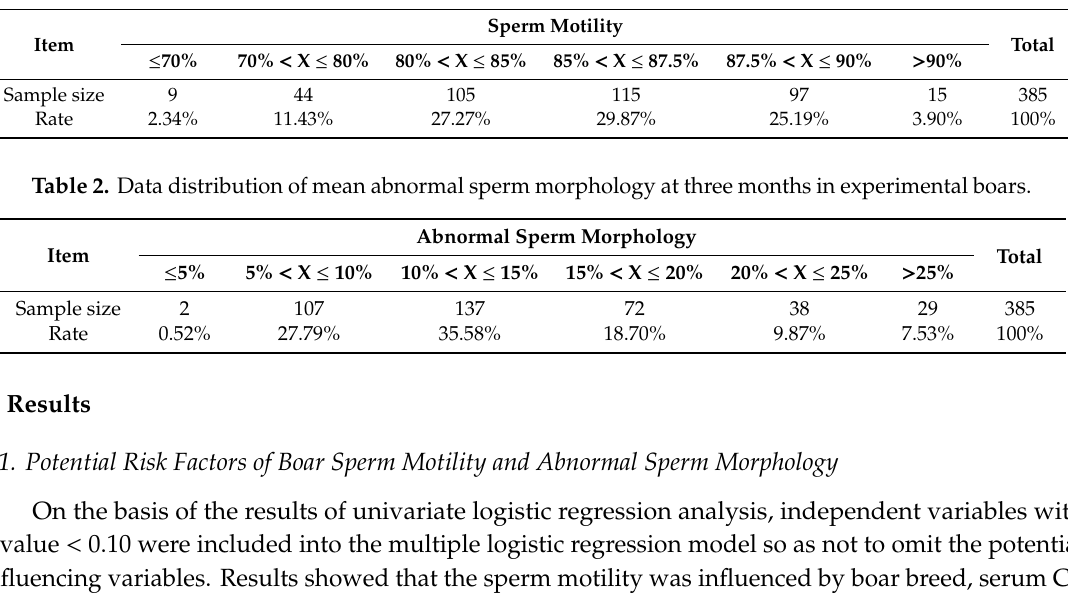
Table 1. Data distribution of mean sperm motility at three months in experimental boars.